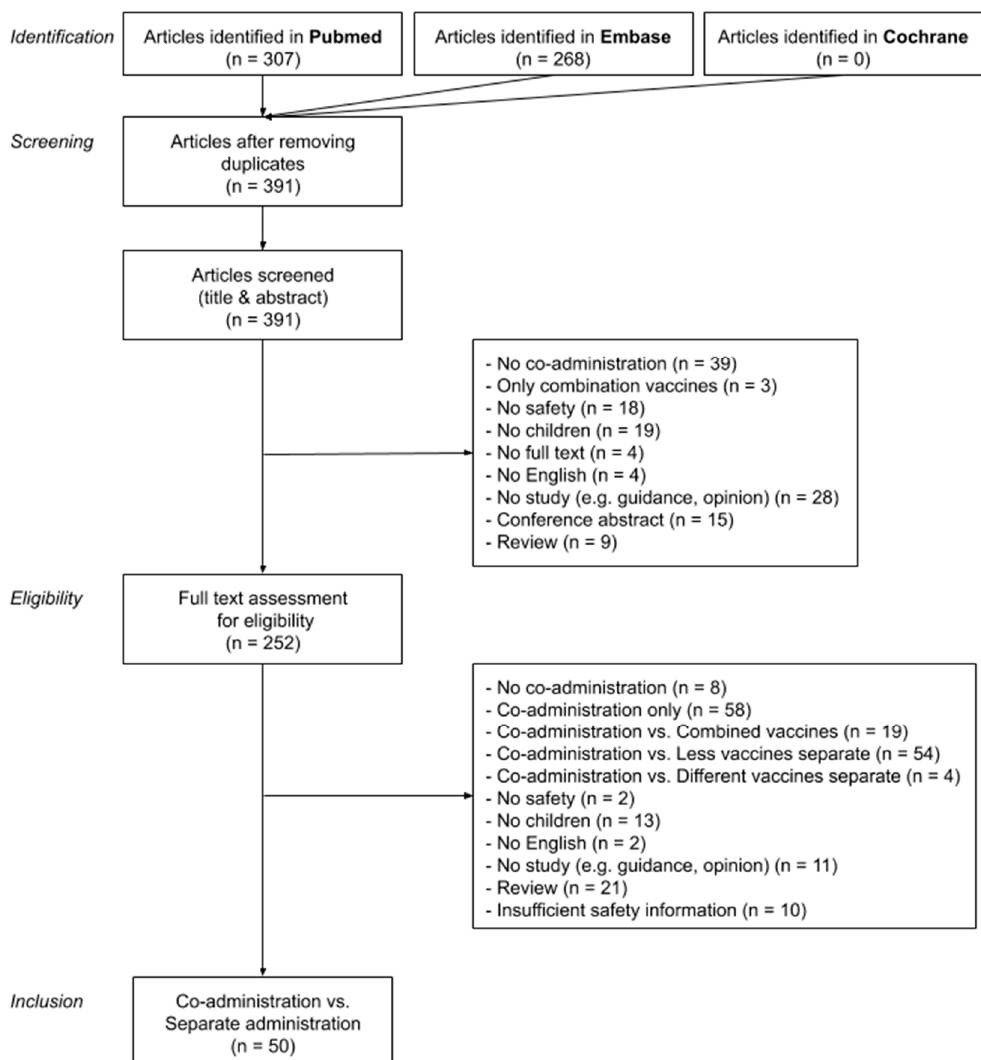
Figure 1. Flow diagram of identifying, screening, assessing eligibility, and including studies.